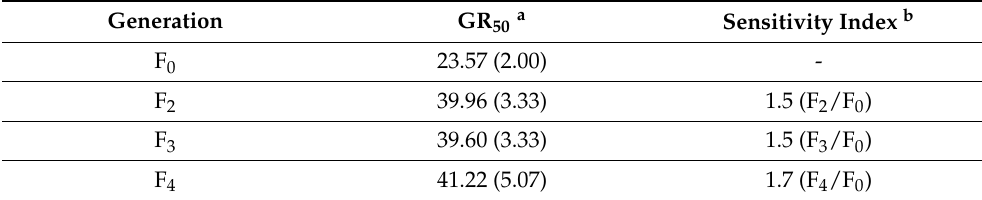
Table 2. The effective mesotrione doses (g ha − 1 ) that caused 50% growth inhibition (GR 50 ) in different generations of A. palmeri collected from an agricultural field.